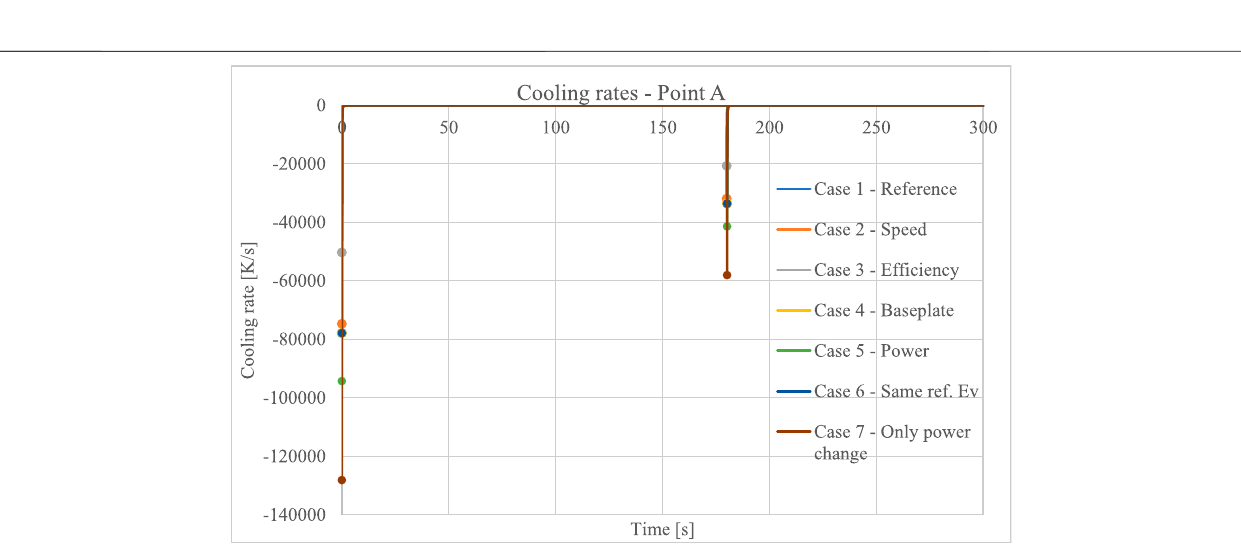
FIGURE 6 | Cooling rates for the top of point A using different sets of build